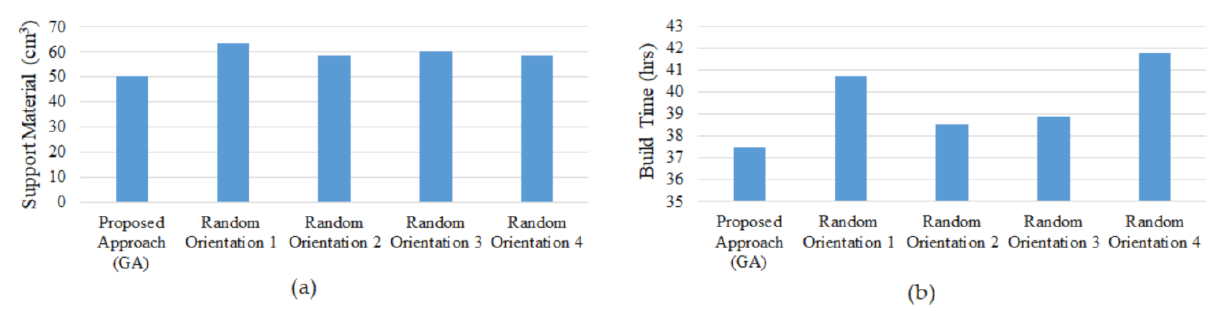
Figure 11. Comparison of optimum and random orientations ( a ) Support Material; ( b ) Build Time.